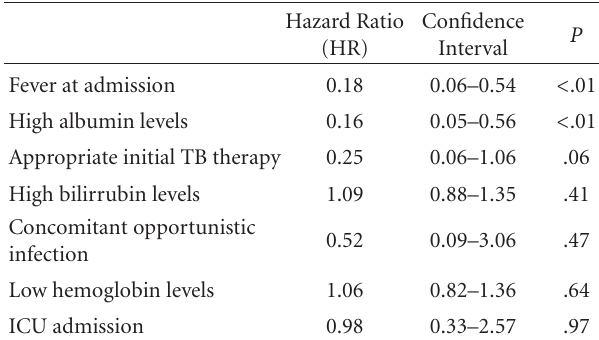
Table 3: Cox regression analysis. Predictors of in-hospital mortality in HIV-infected patients with disseminated tuberculosis ( N =